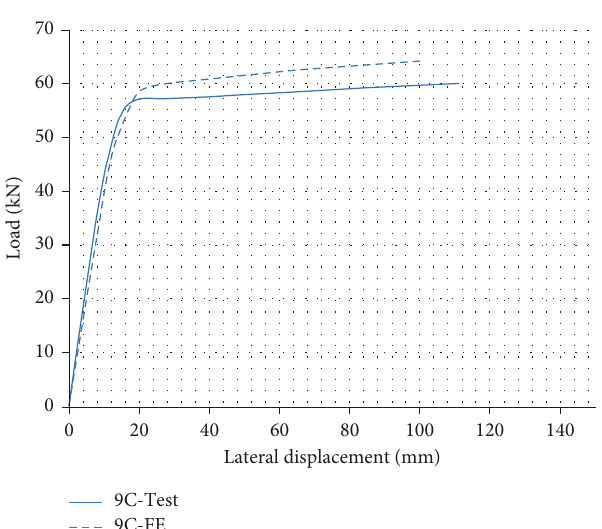
Figure 7: Load-deflection verification curve of test versus FE (specimen